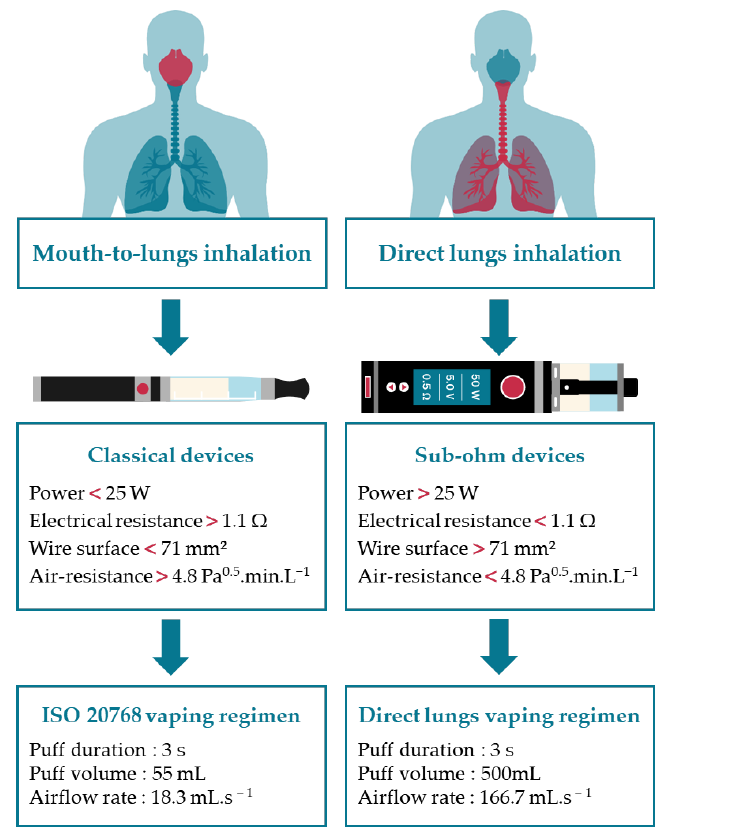
Figure 14. Proposed classification based on mechanical characteristics and advise for vaping regimens selection in the emission generation of electronic cigarette.